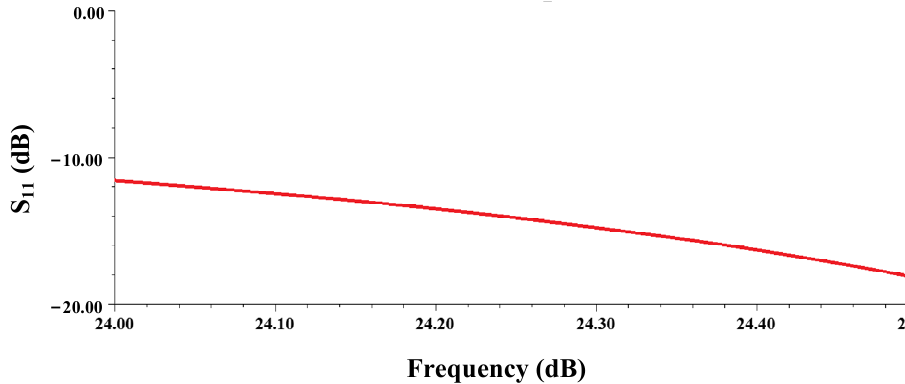
Figure 11. The S 11 results of the proposed antenna.